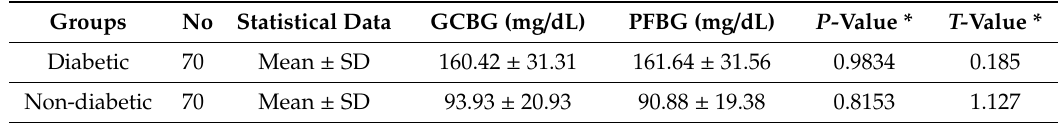
Table 1. Mean and standard deviation measured in both